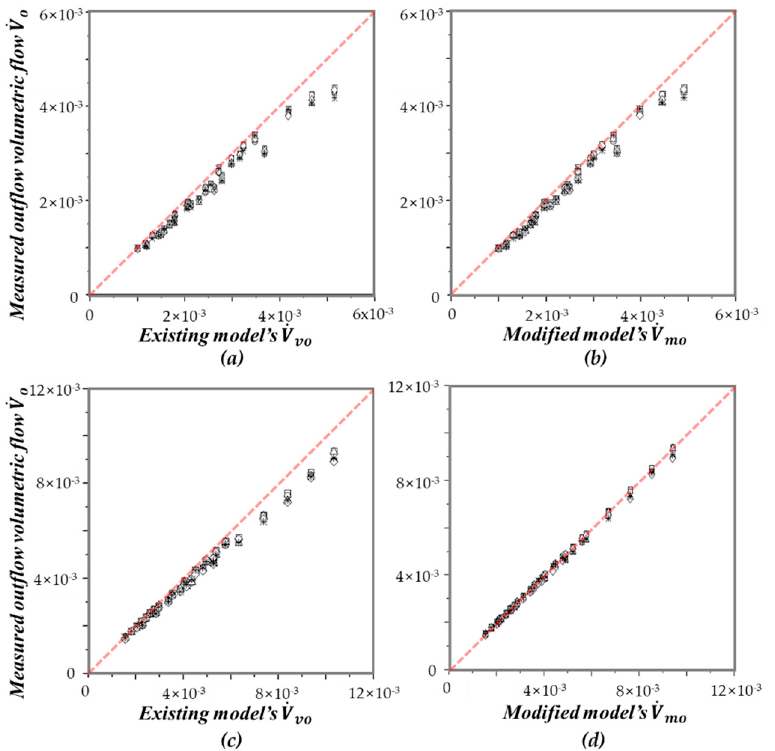
Figure 9. Comparison of theoretical and observed outflow volumetric flow ( c th = 0.5 c mix ) : ( a ) IG-01 , V vo vs. V o ; ( b ) IG-01 , V mo vs. V o ; ( c ) HFC-125 , V vo vs. V o ; and ( d ) HFC-125 , (cid:1848)(cid:4662) (cid:3040)(cid:3042) vs. (cid:1848)(cid:4662) (cid:3042) .